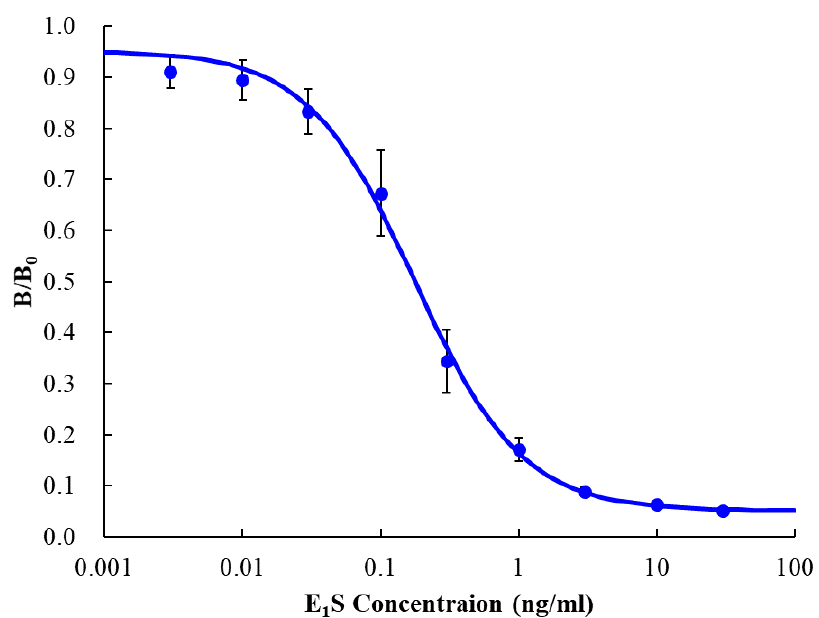
Figure 3. Calibration curve obtained by ELISA (n = 6). The vertical axis of the graph shows B/B 0 , where B and B 0 are the absorbances of each sample and blank, respectively. The error bars represent standard deviations. Figure4ashowsachronoamperogramofeachconcentrationofE 1